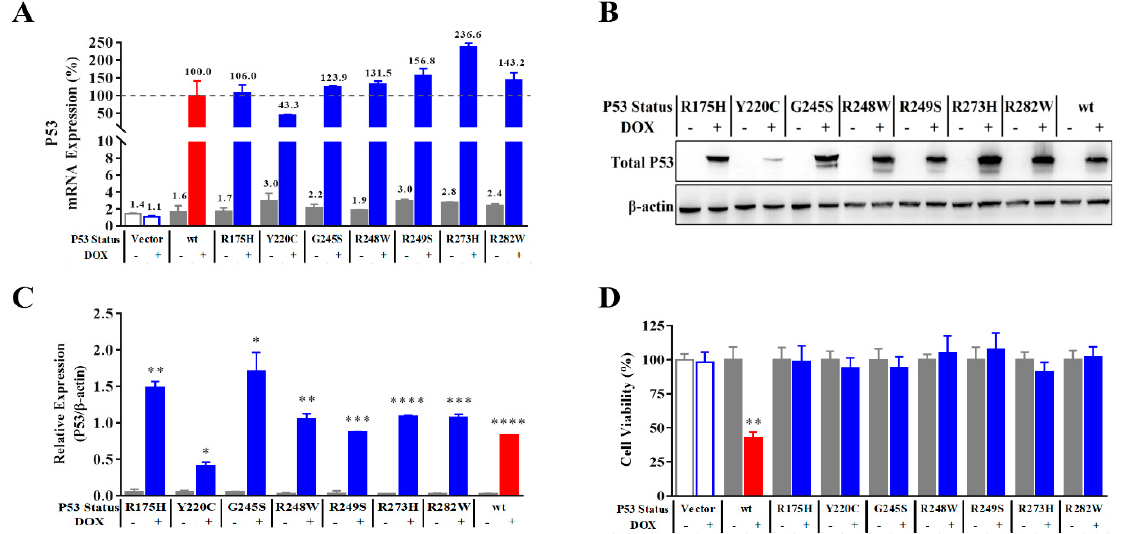
Figure 1. DOX-induced expression of wtP53 or mutP53. ( A ) RT-qPCR analysis of the expression of mRNA showed wtP53 or mutP53 was significantly induced by 0.5 µ g/mL of DOX for 24 h in the cell lines infected with lentivirus containing the coding sequence ( n = 3). ( B ) Band diagrams of total P53 protein in the stable transgenic NCIH1299 cell lines (treated without or with DOX) were determined by Western blot analysis. ( C ) The expression of P53 in the stable transgenic NCIH1299 cell lines was determined by Western blot analysis. ( D ) The cell viability alterations after inducing different statuses of P53 protein for 120 h ( n = 6). Data are presented as the mean ± S.D. obtained from three separate experiments. Compared to the corresponding non-DOX group, * p < 0.05, ** p < 0.01, *** p < 0.001, and **** p < 0.0001.